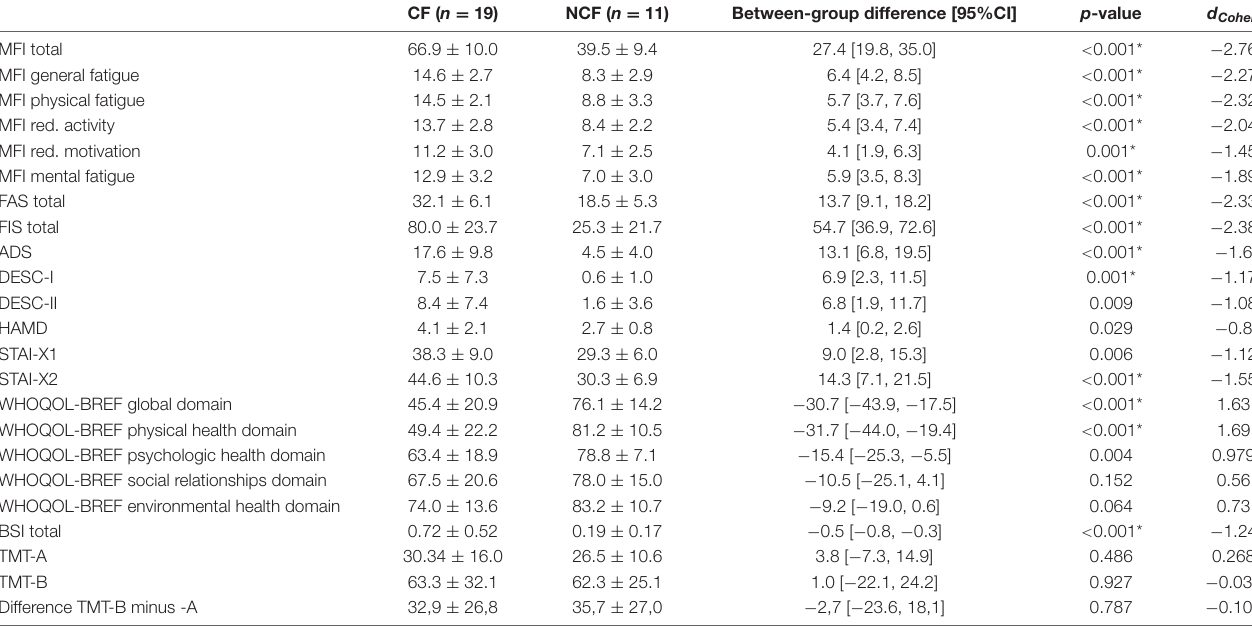
TABLE 3 | Fatigue, depression, quality of life, and executive functioning in sarcoidosis patients with versus without chronic fatigue. CF ( n = 19) NCF ( n = 11) Between-group difference [95%CI] p -value d Cohen